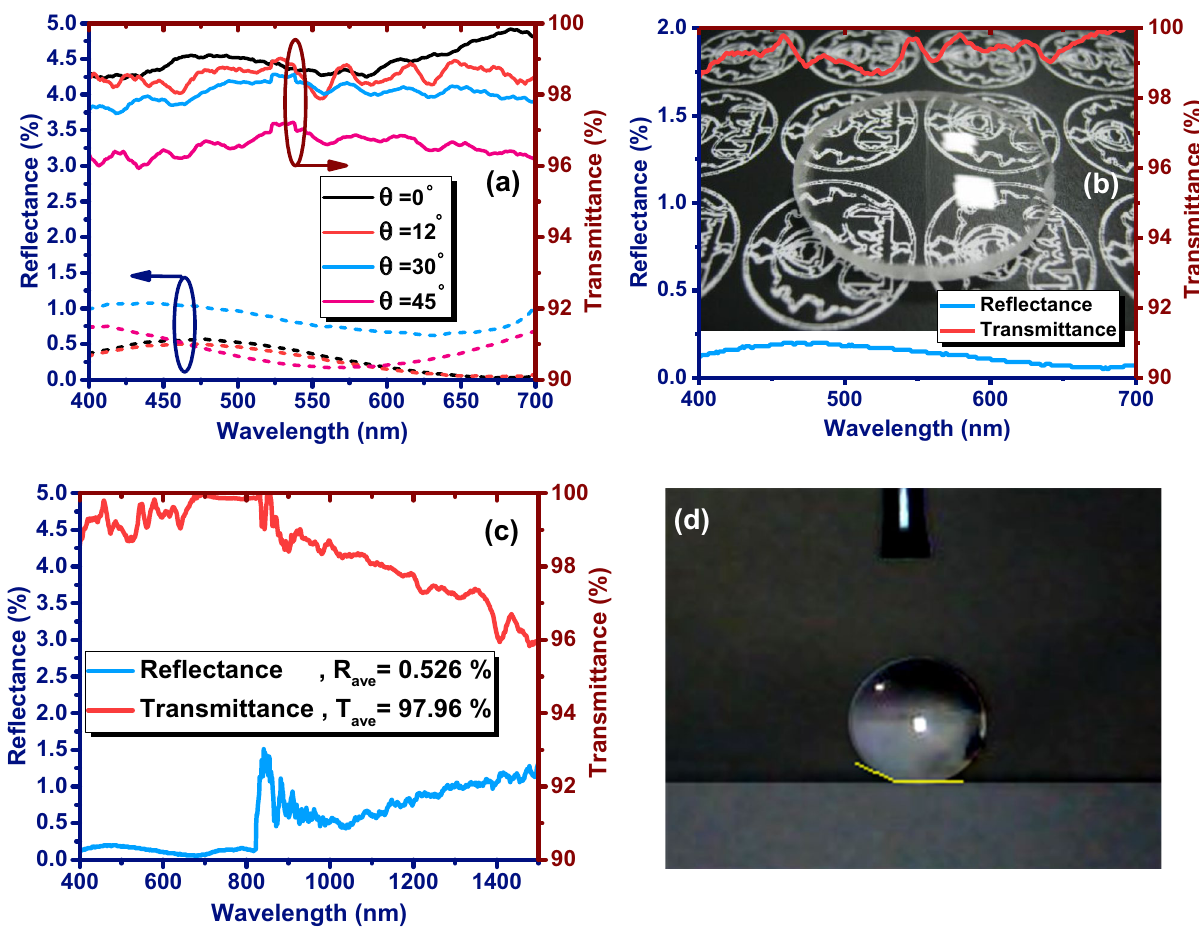
Figure 4. ( a ) Reflectance and transmittance spectra measured from double side coated BK7 substrates with boomerang-like Al in ( b ) shows that the transparency of the BK7 lens (the right part of lens) enhances remarkably in the presence of boomerang-like alumina coating (the left part of lens). ( c ) Reflectance and transmittance across a boomerang- like alumina coated lens surface measured under light at normal incidence. ( d ) Photograph of water droplet on the superhydrophobic surfaces of boomerang-like alumina coated BK7